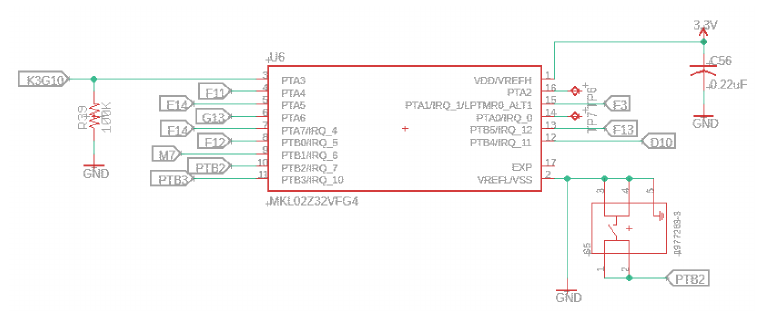
Figure 14. Bootloader